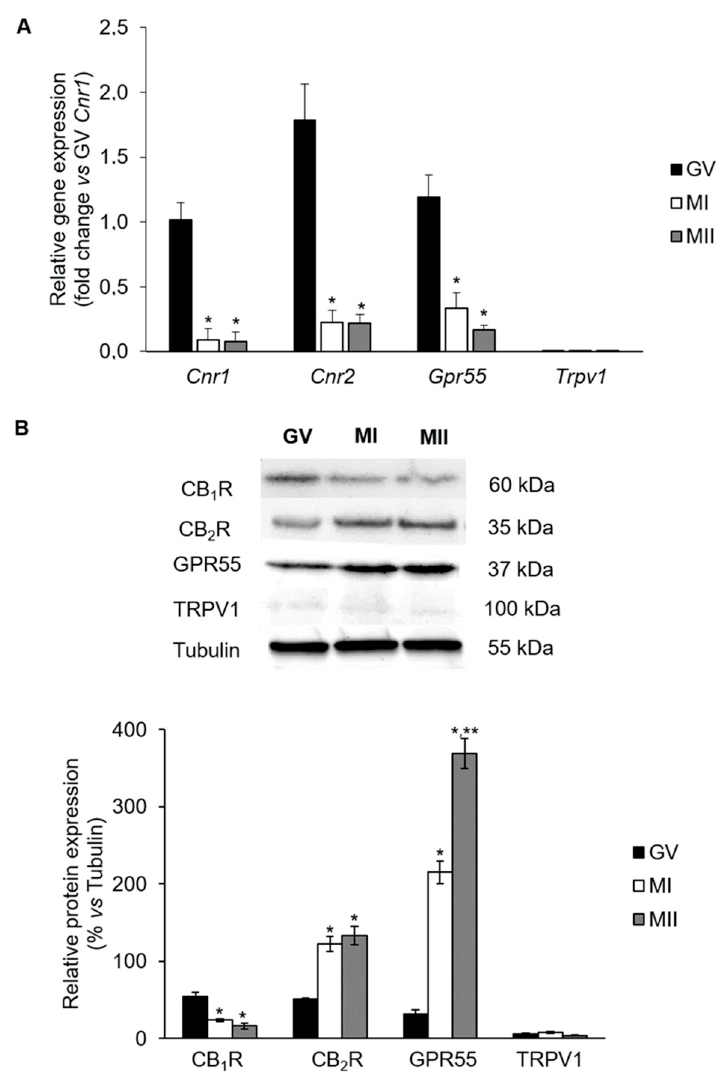
Figure 1. Expression levels of endocannabinoids (eCBs)-binding receptors during mouse oocyte in vivo meiotic maturation. ( A ) Real-time PCR of Cnr1 , Cnr2 , Gpr55 , and Trpv1 . Data were reported as 2 − ∆∆ C t values calculated by Delta–Delta Ct ( ∆∆ C t) method vs. germinal vesicle (GV) ( Cnr1 ) group posed equal to 1. Expression was normalized to Actb and values were reported as mean ± SEM of 4 independent replicates. * p < 0.05 vs. GV oocyte of the same experimental group. ( B ) Representative western blot and quantification of cannabinoid receptor type-1 and -2 (CB 1 R and CB 2 R), G-protein coupled receptor 55 (GPR55), and transient receptor potential vanilloid type 1 channel (TRPV1) protein contents. Data are expressed as mean ± SEM of each receptor content after normalization with α / β -tubulin, used as loading control. Experiments were repeated 3 times. * p < 0.05 vs. GV oocyte of the same experimental group; ** p < 0.05 vs. MI of the same experimental group. GV = germinal vesicle; MI = metaphase I; MII = metaphase II.